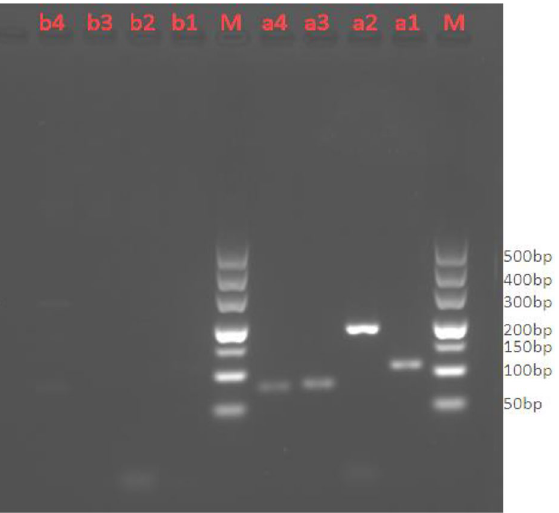
Figure 5. Verification of the specificity of the target gene. Lane M: 500 bp DNA marker, lanes a1–a4: human blood DNA (template DNA used to amplify the target genes GAPDH (106 bp), TH01 (234 bp), TPOX (79 bp) and D7S820 (77 bp), with clear amplified bands. Lanes b1–b4: mouse liver DNA (template used to amplify the target genes GAPDH, TH01, TPOX and D7S820), with no amplified bands.